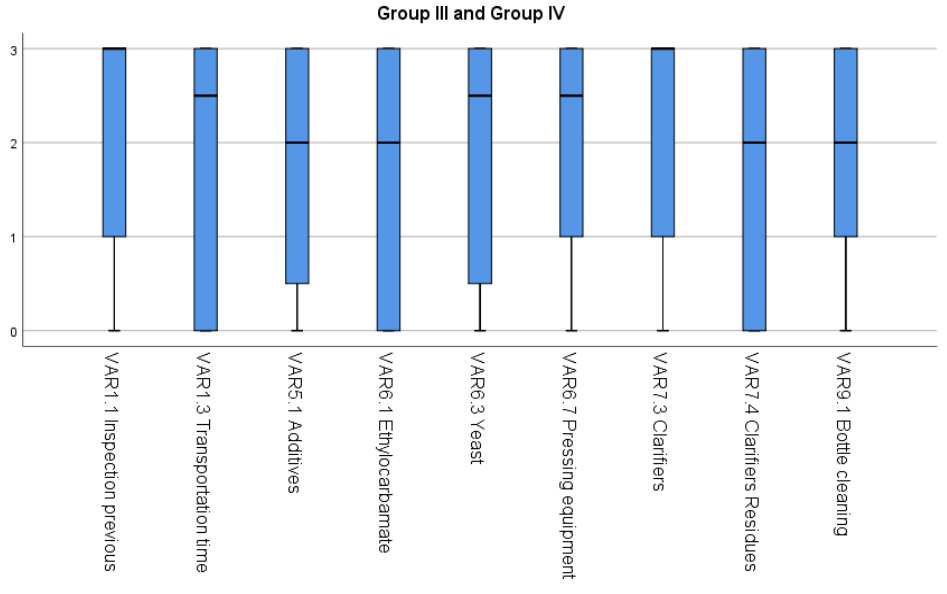
Figure 3. Median and range interquartile for variables included in Group III and Group IV.